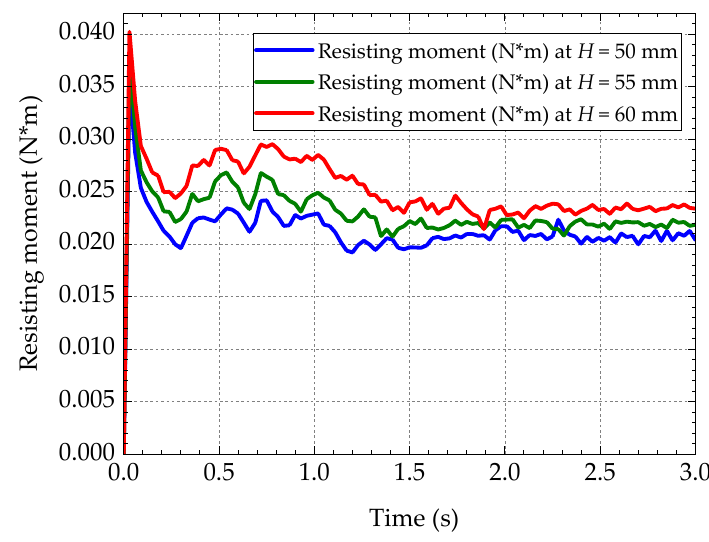
Figure 12. Change rules of fluid resisting moment versus time. The flow rate (scatter in Figure 13) and its 10-point moving average value (line in Figure 13) passing through flow Monitoring Plane 2 are given in Figure 13. At an oil level of 55 mm and 60 mm, the oil reaches the top of the oil-guiding cylinder at about 0.3 s, and then the flow continues to rise to reach a peak and slowly decreases to be stable. Although the peak of the average flow rate varies greatly, the average flow rate is basically the same when the flow reaches relative stability at about 1.5 s, while for the oil level of 50 mm, the moment that the oil reaches the top, and the peak appears inclines to delay for the oil level of 50 mm. Additionally, the flow rate is clearly lower than that of 55 mm and 60 mm.